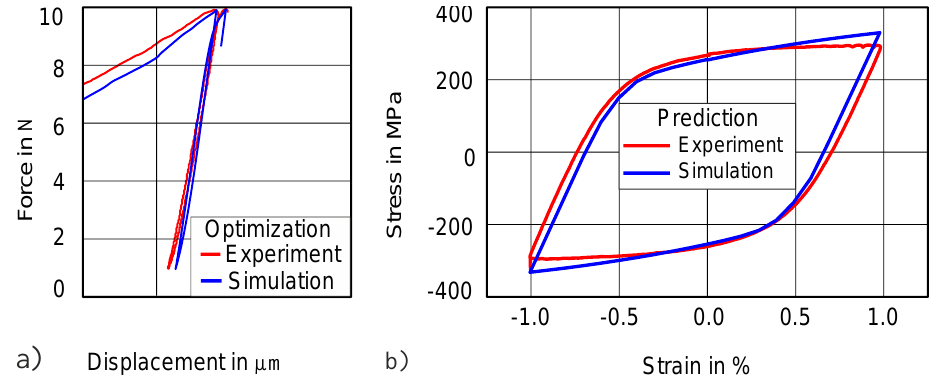
Figure 13. Transferability of method: ( a ) simulated indentation force – displacement of Cu at 10 N; ( b ) prediction of uniaxial stress – strain hysteresis. Table 4. Identified material parameters of the force – displacement loop for Cu at 10 N force amplitude. Symbol. Value